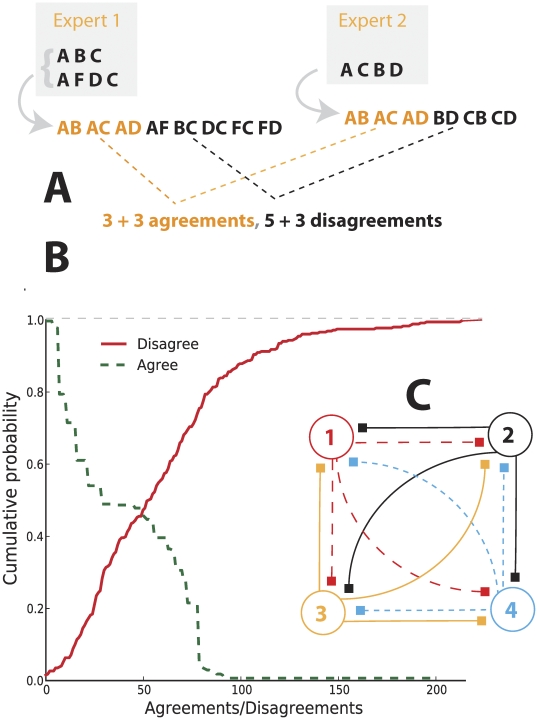
Quantifying the agreement between expert scenarios of metastasis.(A) A hypothetical example of scenarios produced by two experts (experts 1 and 2). Expert 1 suggested two alternative scenarios (ABC and AFDC), while expert 2 suggested only one (ACBD). We define the agreement/similarity between experts as twice the number of stage pairs they share, of all possible ordered pairs of stages from each scenario. We define the disagreement/dissimilarity as the agreement minus the sum of unmatched pairs; see the example. (B) Cumulative probabilities that two experts agree at least at level x (similarity of x or greater), and that two experts disagree at level x or less. The probability of agreement drops rapidly as the number of statements from each expert increases, while the probability of disagreement grows gradually to a rather large number of pairwise disputes. (C) A hypothetical four-expert “regulatory deadlock” could occur if any one of the experts insisted on his disagreement with all others.